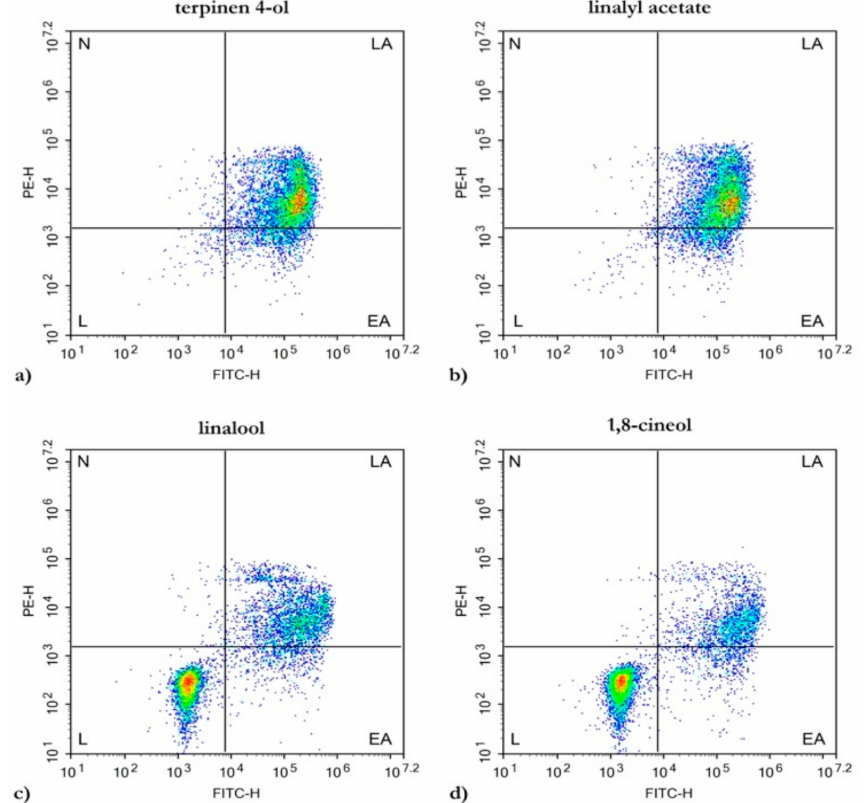
Figure 4. Evaluation of apoptosis in HL60 cells induced by treatment with the main LEO compounds. Flow cytometry analysis for Annexin V-FITC / PI staining. ( a ) terpinen-4-ol; ( b ) linalyl acetate; ( c ) linalool; ( d ) 1,8-cineole. (L) live cells, (EA) early apoptotic cells, (LA) late apoptotic cells, (N) necrotic